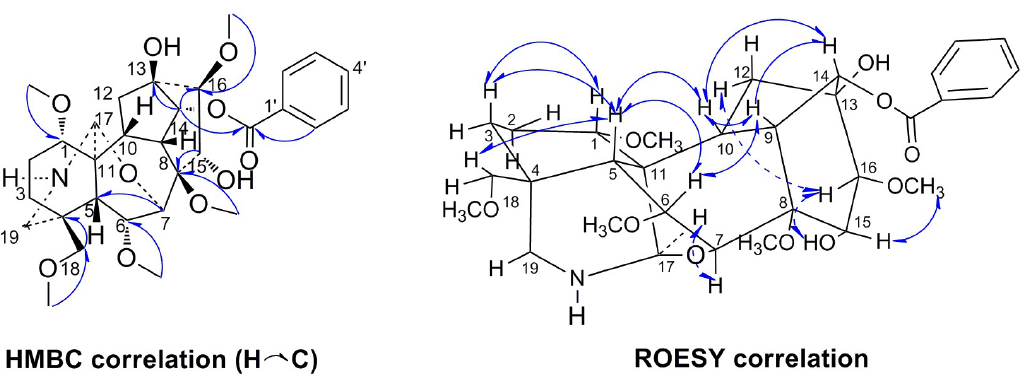
Figure 2. Key HMBC (H → C) and ROESY (H ↔ H) correlations of Compound 1 . Szechenyianine E ( 2 ) was isolated as a white amorphous powder and showed a positive reaction with Dragendorff′s reagent. Its molecular formula C 39 H 55 NO 11 was derived from the protonated molecular ion peak at m / z 714.3840 [M + H] + (calcd.714.3853) in the HR-ESI-MS spectrum. The 1 H-